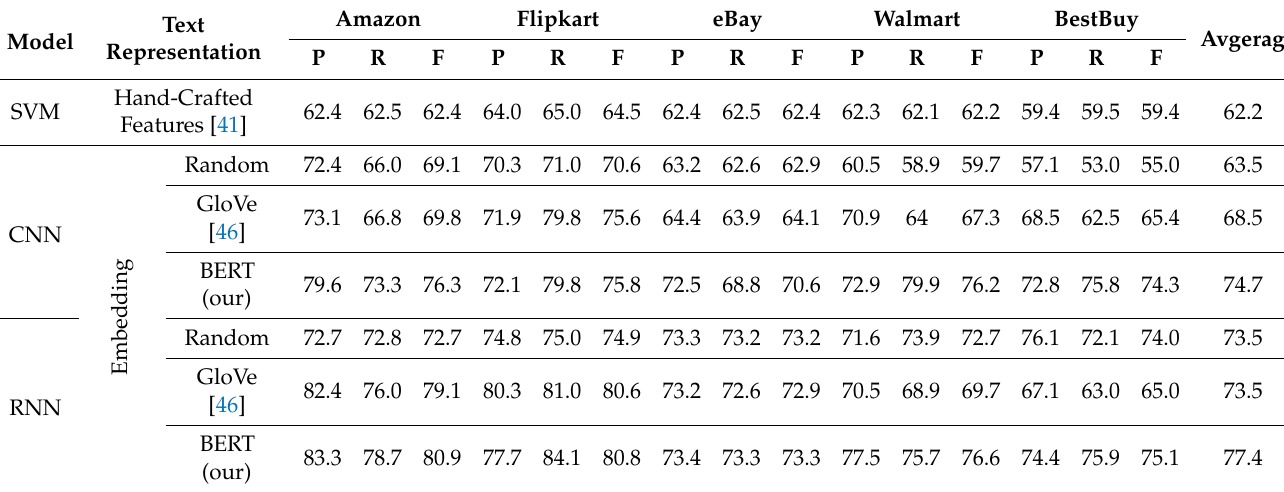
Table 5. Comparison results for hierarchical aspect extraction phase in our system on our LC5 dataset. SVM: support vector machine; CNN: convolutional neural network; RNN: recurrent neural network.